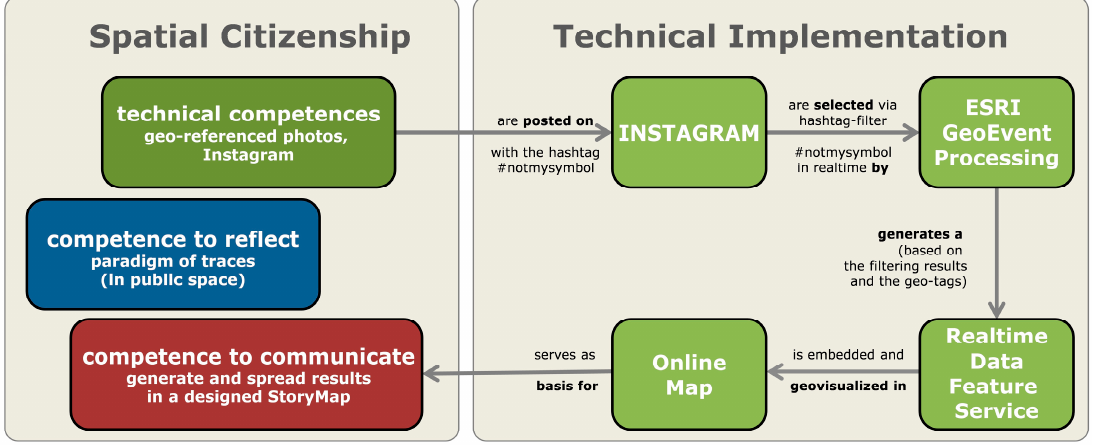
Figure 1. Basic model for spatial citizenship and technical implementation in #notmysymbol (from: [22], Austrian Academy of Sciences Press, CC BY-ND 4.0.